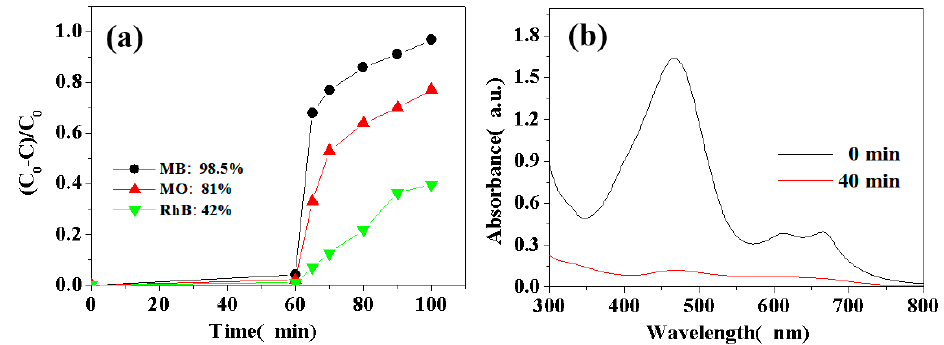
Figure 7. ( a ) Degradation rate value curves of different dyes at the same time. ( b ) Photocatalytic degradation curves of the mixed dyes.